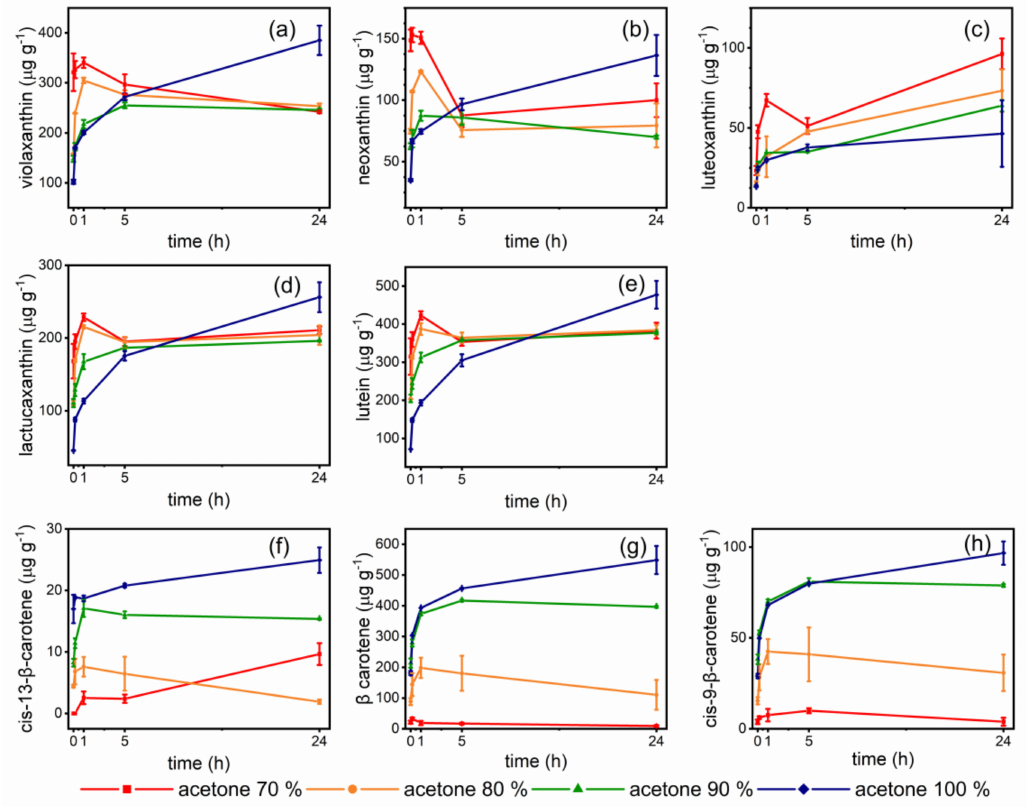
Figure 1. Carotenoids extracted from lettuce microgreens with di ff erent acetone:water mixtures and varying extraction times. ( a – e ), xanthophylls; ( f – h ), carotenes. Error bars indicate standard deviation. Results of ANOVA and post-hoc Tukey’s test are reported in Supplementary Table